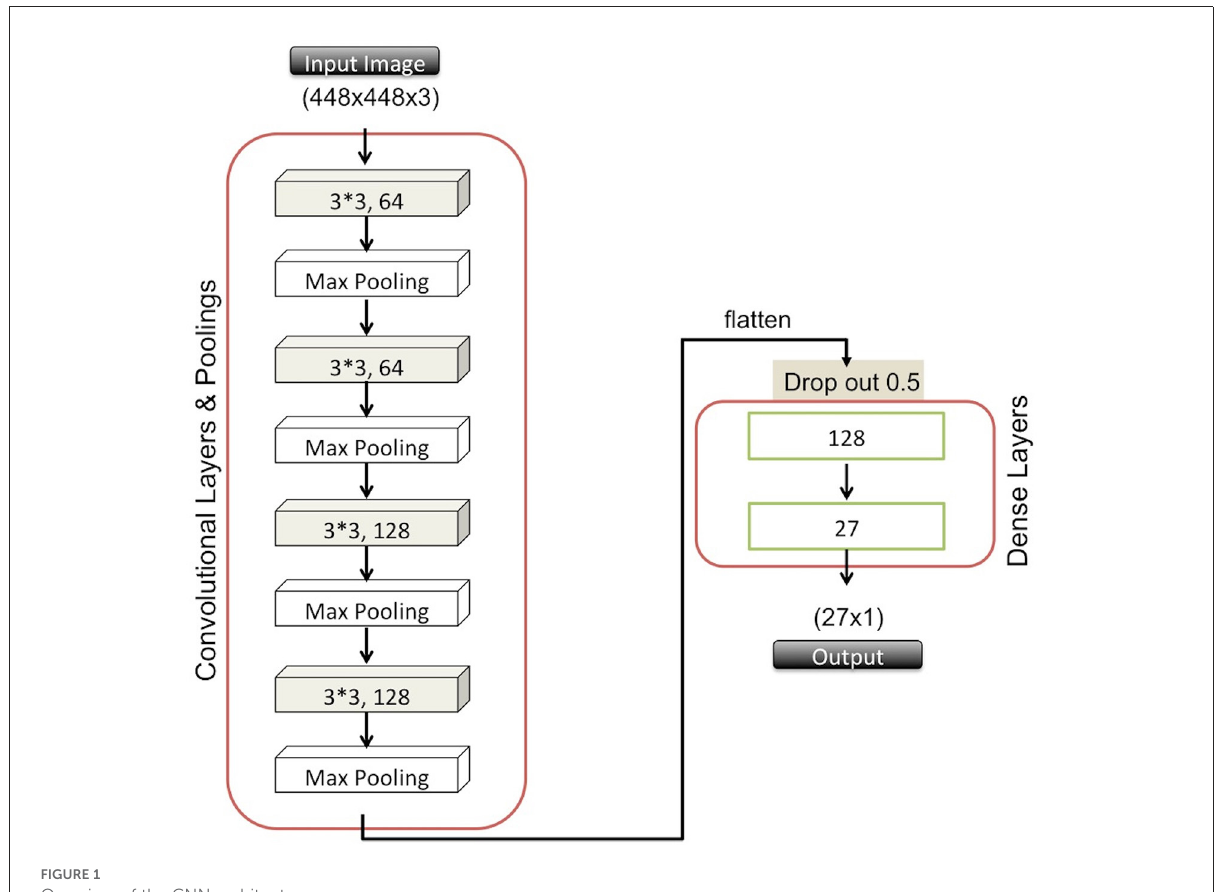
FIGURE1 Overview of the CNN architecture.